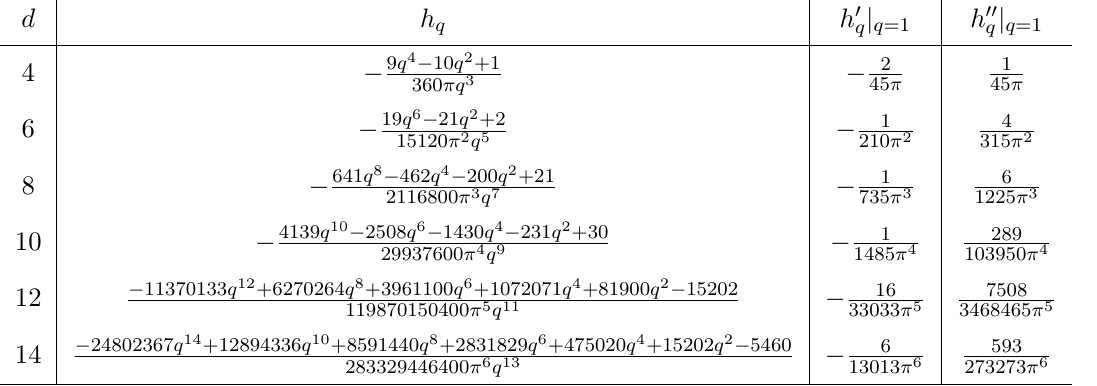
Table 3 . Conformal dimension of the twist operator of the four-derivative Weyl invariant scalar. parameters determining the two and three-point functions of the stress tensor [2, 22].